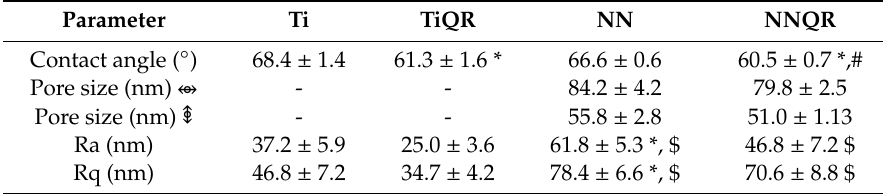
Table 1. Physical characterization of the different titanium surfaces. Values represent the mean ± S.E.M. ° = water contact angle, ⥈ = pore width, = pore length, Ra = average roughness, Rq = root mean square. Results were statistically compared by an ANOVA and Bonferroni as post hoc: * p < 0.05 versus Ti; $ p < 0.05 versus TiQR and # p < 0.05 versus NN.